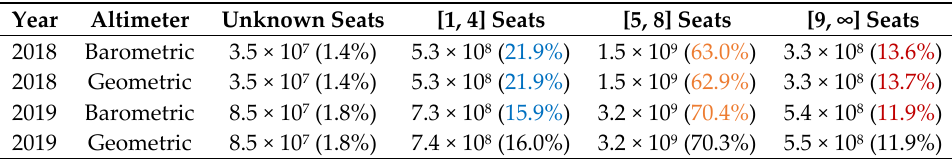
Table 5. Frequency of rotorcraft operating at or below 18,000 feet AGL.